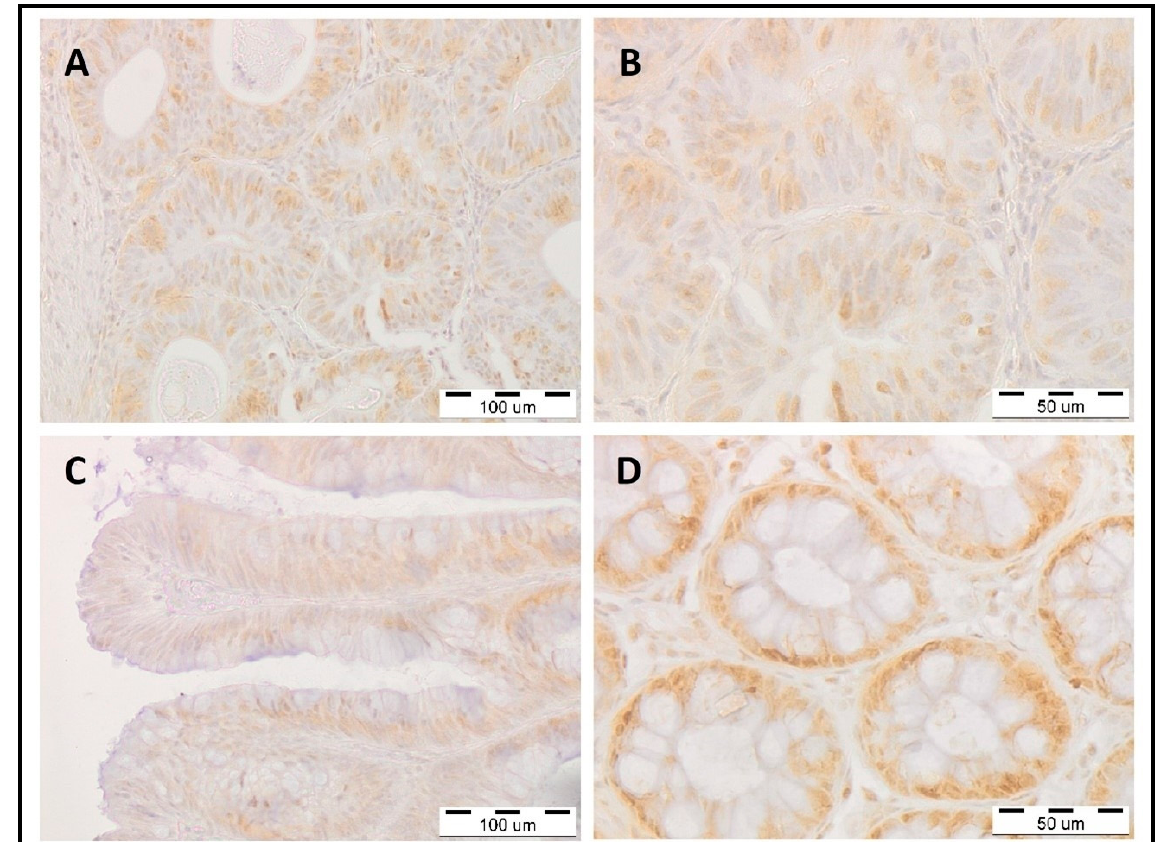
Figure 2. Immunohistochemical staining against POLD1 within tissues of the human large intestine. ( A , B ) Represent POLD1 expression in the colon cancer tissue; ( C ) POLD1 expression in villous adenomas; ( D ) POLD1 expression in epithelial cells of normal mucosa of the large intestine, view of the transverse section of intestinal crypts. All sections were stained using immunohistochemical methods: primary antibody—rabbit anti-human antibody against POLD1 (HPA046524; Sigma-Aldrich, St. Louis, MO, USA), next—secondary antibody HRP-conjugated (ready-to-use dilution; ImmPRESS Universal reagent Anti-Mouse/Rabbit Ig, Vector Laboratories). Finally, the sections were stained in diaminobenzidine (DAB; Dako, Glostrup, Denmark) and counterstained with hematoxylin (Sigma- Aldrich, St. Louis, MO, USA). The magnification was ( A , C ) 200× and ( B , D ) 400×; particular bars are labeled in each photo.